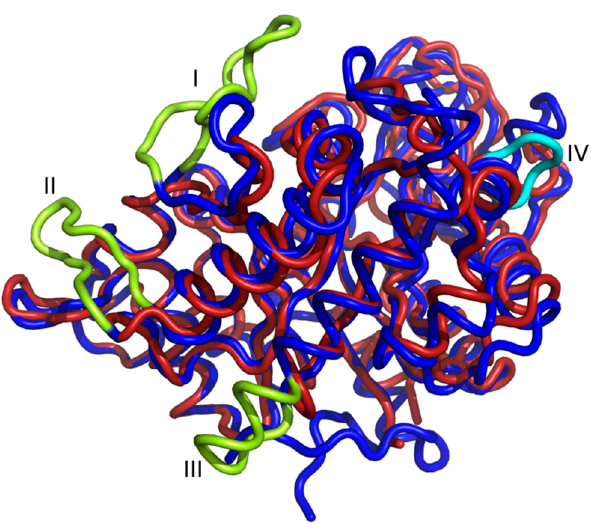
Figure 3. Superposition of St Chi40 (red) with psychrophilic chitinase B from Arthrobacter (blue). Loops absent in St Chi40 are shown (lime): between β 2 and α 2 (I), between α 3 and β 4 (II) and between α 4 and β 5 (III); the loop absent in chitinase B between β 5 and α 5 is colored cyan.